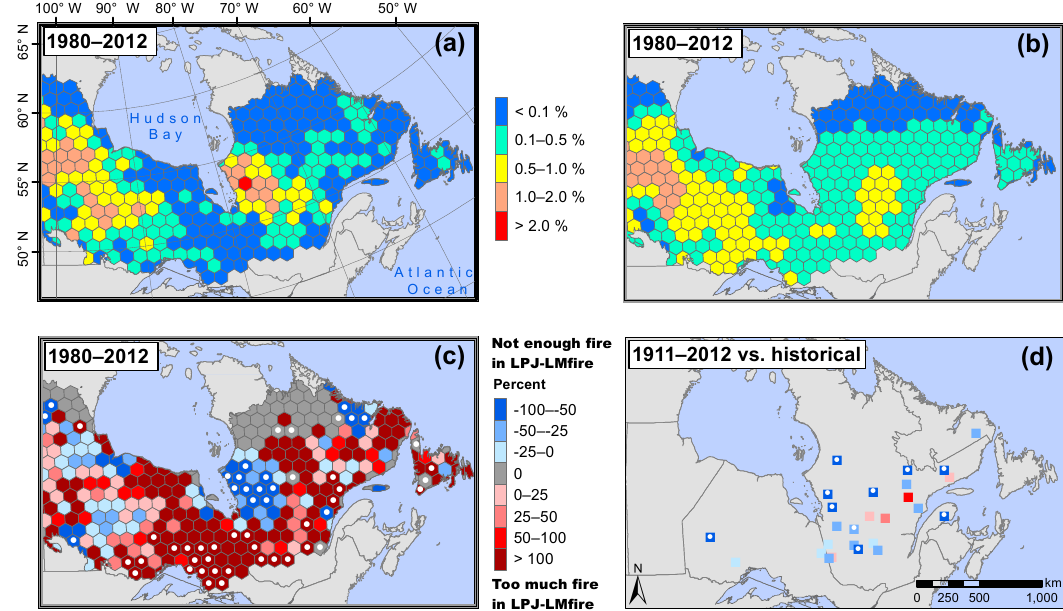
Figure 2. Observed versus LPJ-LMfire-simulated annual burn rates across eastern boreal Canada. (a) Observed annual burn rates computed for 365 hexagonal cells between 1980 and 2012 (data from Natural Resources Canada, 2017). (b) LPJ-LMfire simulated annual burn rates computed over the same period and hexagonal cells. (c) Percent age of difference between observed and simulated annual burn rates. (d) Percent age of difference between historical annual burn rates reconstructed from stand-replacing fire history studies (data from Girardin et al., 2013b; Héon et al., 2014; Portier et al., 2016) and LPJ-LMfire-simulated annual burn rates between 1911 and 2012 (see Supplement S4 for further details). White points indicate where the observed (and historical) annual burn rate lies outside the 95% confidence interval (95% CI) of the averaged annual burn rates in hexagonal cells simulated by